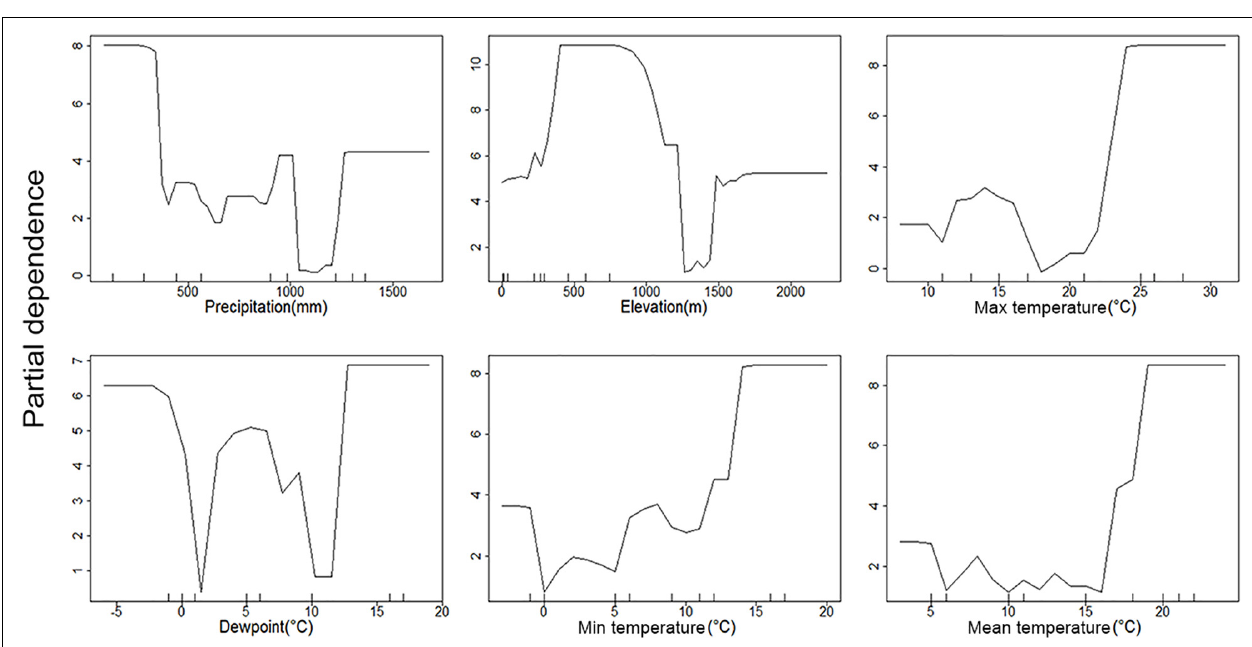
FIGURE 4 | Partial dependence plots of environmental parameters showing their association with C . pipiens occurrence. Y-axis is partial dependence to accurately predict C . pipiens occurrence.